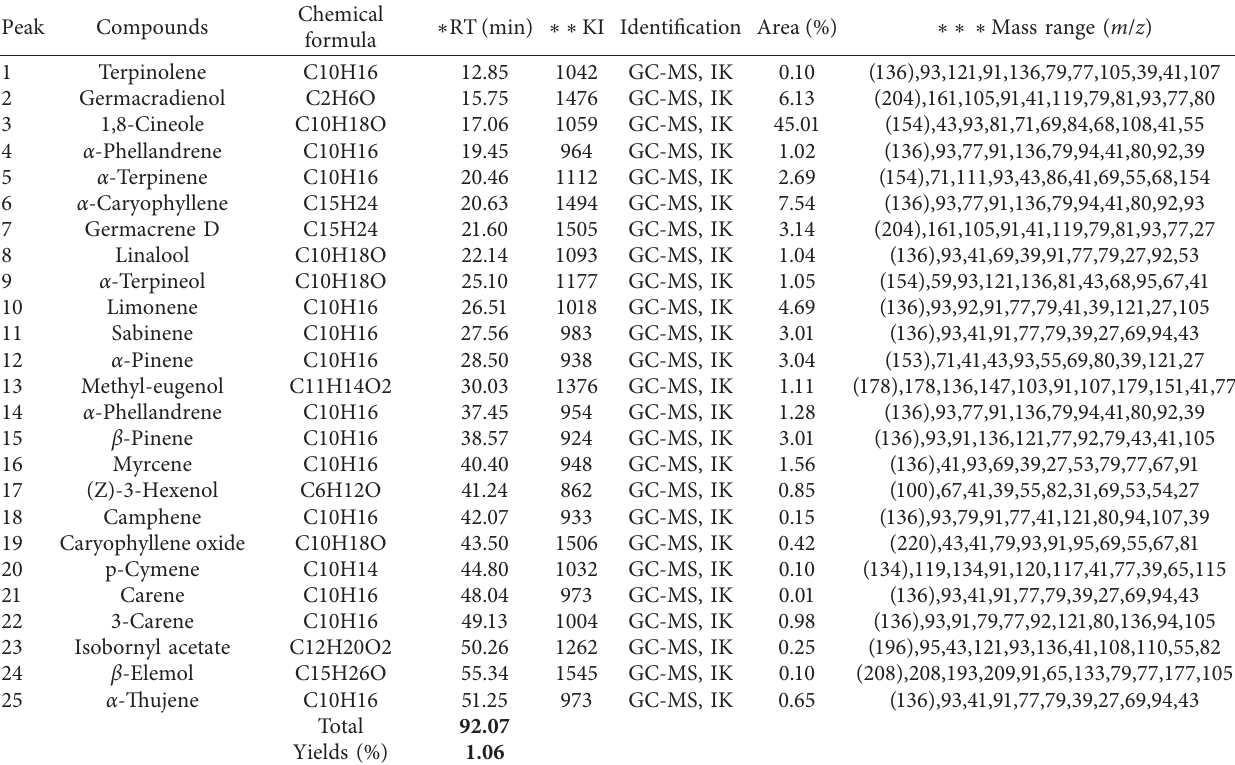
Figure 1: Chromatogram of essential oil from L. nobilis flowers. Table 1: Phytochemical analysis of essential oil from L. nobilis